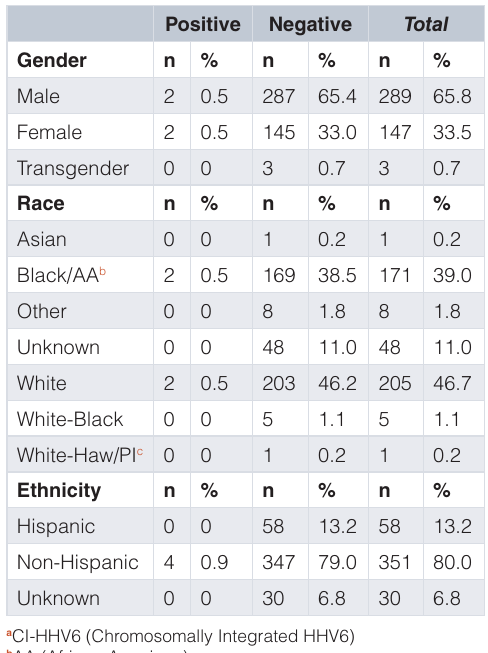
Table 1. Demographic data by presence or absence of CI-HHV 6 a detected by quantitative PCR.